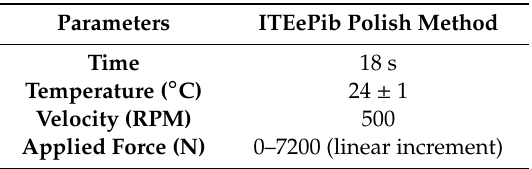
Table 2. Four-ball tribotest evaluation